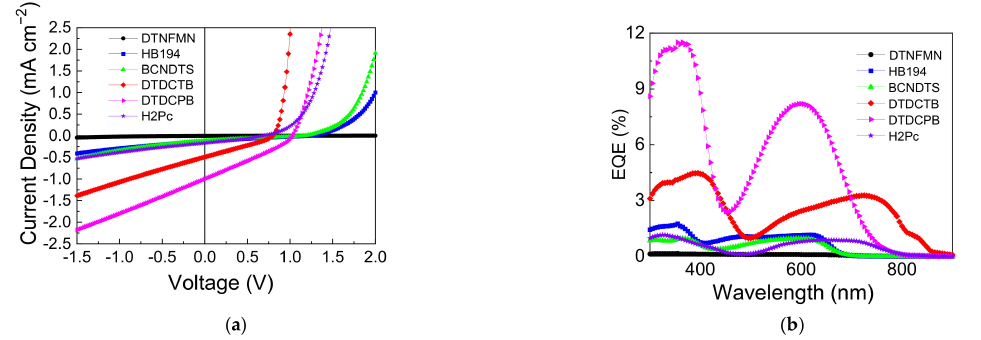
Figure 3. ( a ) J – V curves of the single-component photovoltaic cells under dark and AM1.5G illumi- nated conditions. ( b ) External quantum efficiency (EQE)